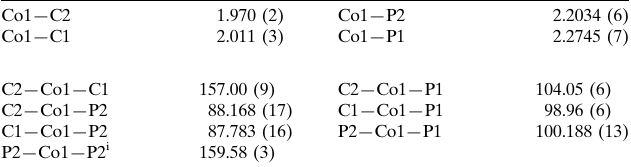
Selected geometric parameters (A˚ , (cid:3)